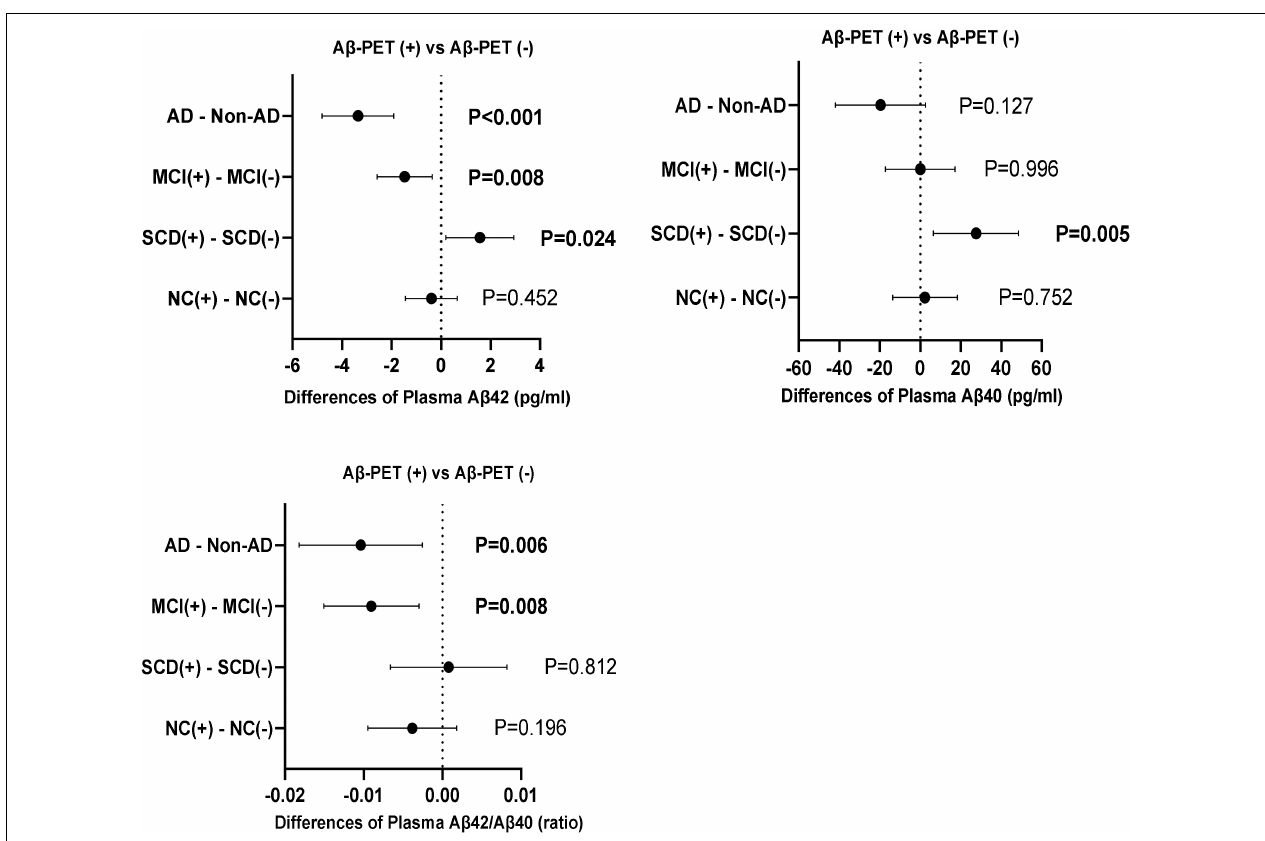
FIGURE 4 | Differences of plasma A β 42, A β 40, and A β 42/A β 40 between A β -PET (+) and A β -PET (–) in the diagnostic groups of NC, SCD, MCI and dementia. P -values were adjusted for age, sex, and education years.